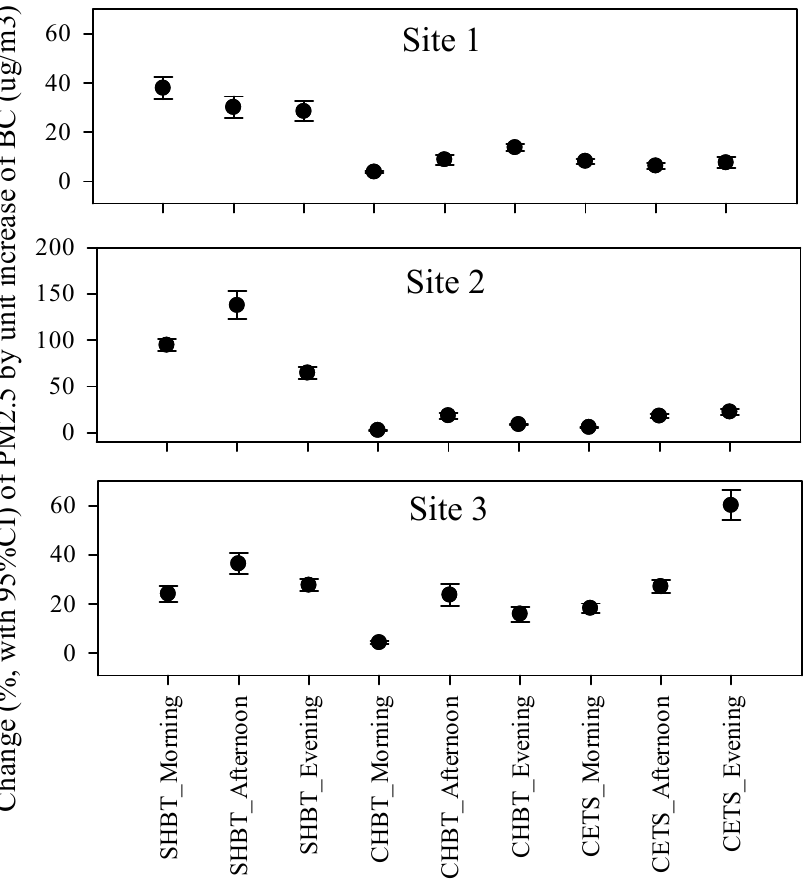
Figure 3. Impact of variation of BC concentration on PM 2.5 concentrations at each sampling site and sampling time evaluated by the % change of PM 2.5 concentrations by unit increase of BC ( μ g/m 3 ).